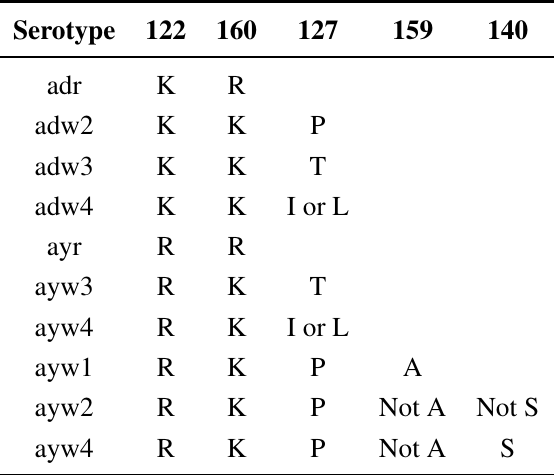
Figure 6. The output page of the “Wild-type 2 × 2” tool. The first table shows positions at which the p -value is less than or equal to the threshold specified, the wild-type residue, the Fisher’s exact test p -value (“pFET”), a list of the mutant residues found in Group 1 and a list of the mutant residues found in Group 2. At least one value in the 2 × 2 contingency table for each row in the table was less than or equal to five, so chi-squared tests were not performed in these cases. An offset value was specified on the input page, so the positions on the output page are adjusted accordingly. The next section of output shows the 2 × 2 contingency tables for each position listed in the first table. This output indicates that there is a statistically-significant difference at the 5% level, between HBV isolates from males and females at positions 1766 and 1812 of the basic core promotor (BCP) region. Table 2. The decision tree, from [15], represented as a table. For each serotype, the required amino acids are indicated in the appropriate column. The numbered columns indicate the amino acid position within